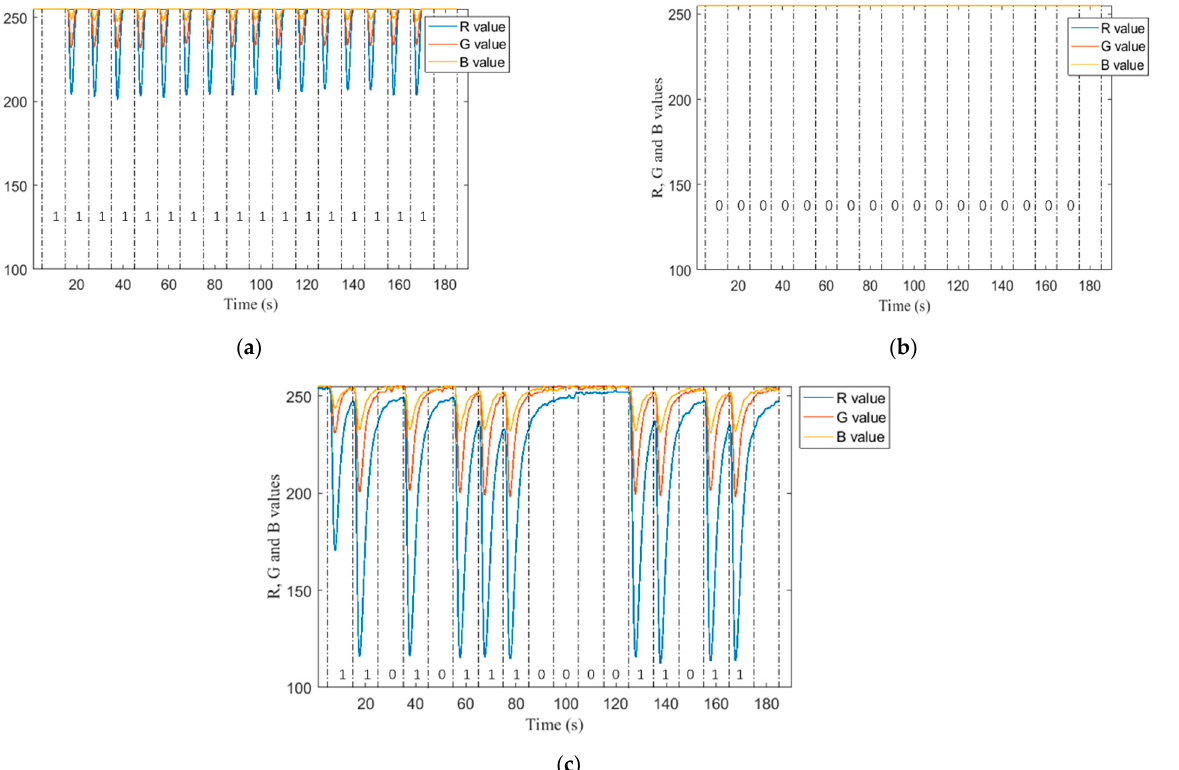
Figure 3. R, G and B values when sending different sequences. The background flow rate is set to 66 mL/min, the k value is 0.05. ( a ) R, G and B values when sending 17-bit full 1 sequence; ( b ) R, G and B values when sending 17-bit full 0 sequence; ( c ) R, G and B values when sending 17-bit {1,1,0,1,0,1,1,0,0,0,0,0,1,1,0,1,1,1,1,1,1} sequence.